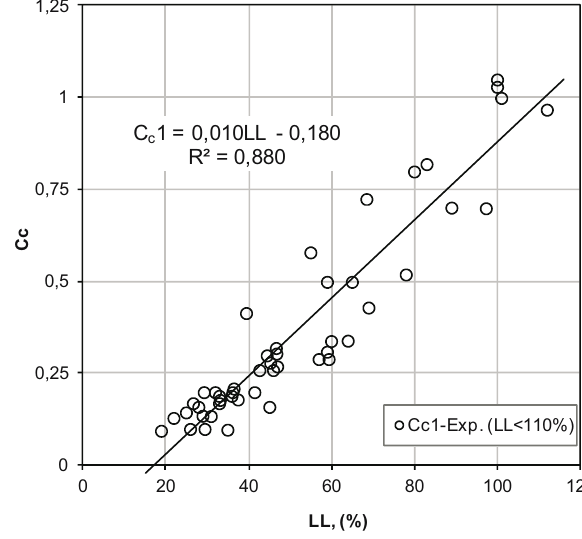
Figure 4: Best - fi t relationship of C c1 / G versus LL < 110%.